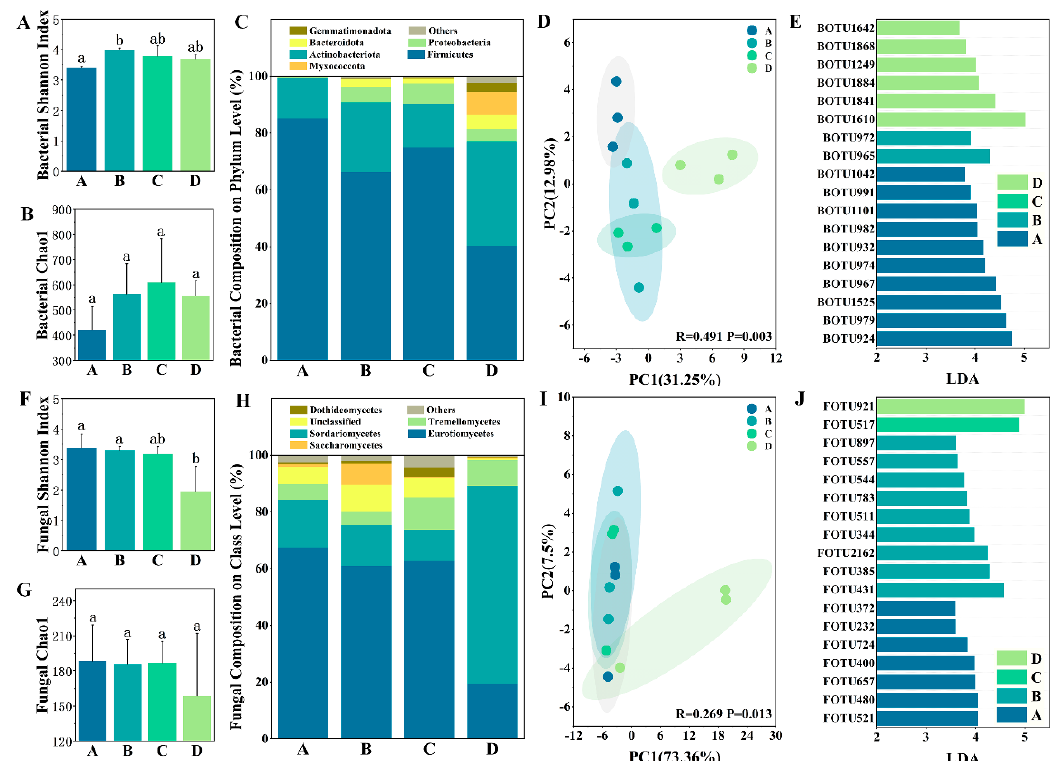
Figure 2. Variation on microbial community diversity indexes, composition, and distinctive mem- bers. ( A , B , F , G ) depicts the change in Shannon indexes and Chao1 indexes, the letters a and b indi- cate significant differences at p < 0.05 level (Turkey’s HSD). ( C , H ) depicts the compositional barplot. ( D , I ) depicts the PCoA analysis results, the R-value and p -value are generated from ANOISM anal- ysis. ( E , J ) depicts Lefse analysis results of bacterial and fungal OTUs, respectively. The OTU with LDA-value more than 3.5 are exhibited.